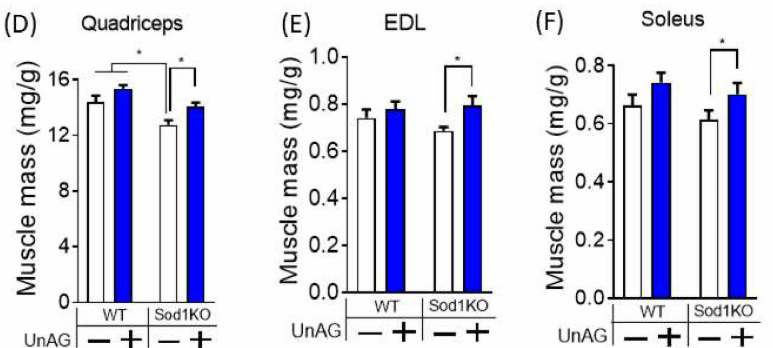
Figure 4. Unacylated ghrelin treatment increases skeletal muscle mass in redox-dependent sarcopenia independent of changes in food consumption or body weight. Unacylated ghrelin does not alter food intake ( A ) or body ( B ) of wildtype mice. ( C , D ) Unacylated ghrelin preserves the loss of muscle mass of gastrocnemius and quadriceps in Sod1KO mice. ( E , F ) Unacylated ghrelin increases muscle mass of EDL and soleus in Sod1KO mice. Two-Way ANOVAs were used to test statistical significance between groups, followed by Tukey post hoc tests. Data are mean ± SEM. * p < 0.05. Abbreviations: UnAG, unacylated ghrelin; EDL, extensor digitorum longus.